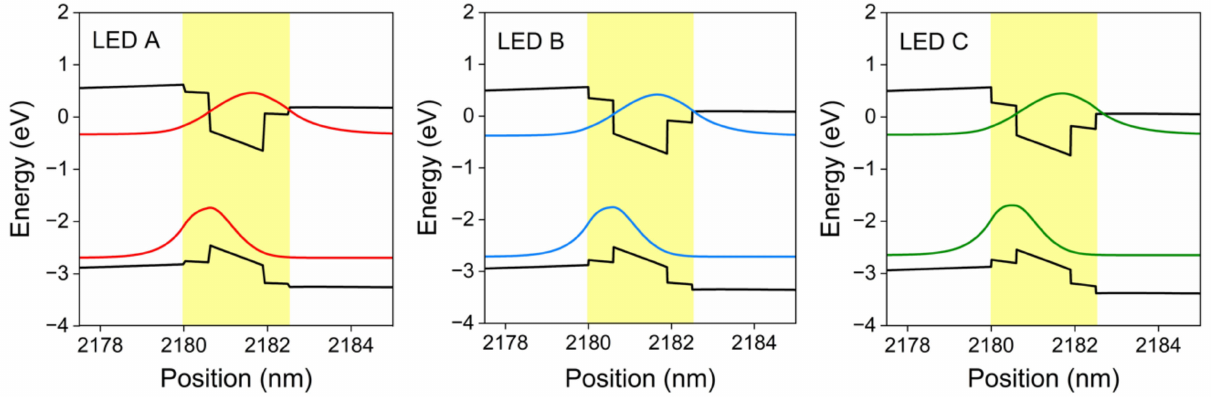
Figure 6. Simulated energy band diagram and carrier wavefunctions of the QW closest to p-side for LEDs A, B and